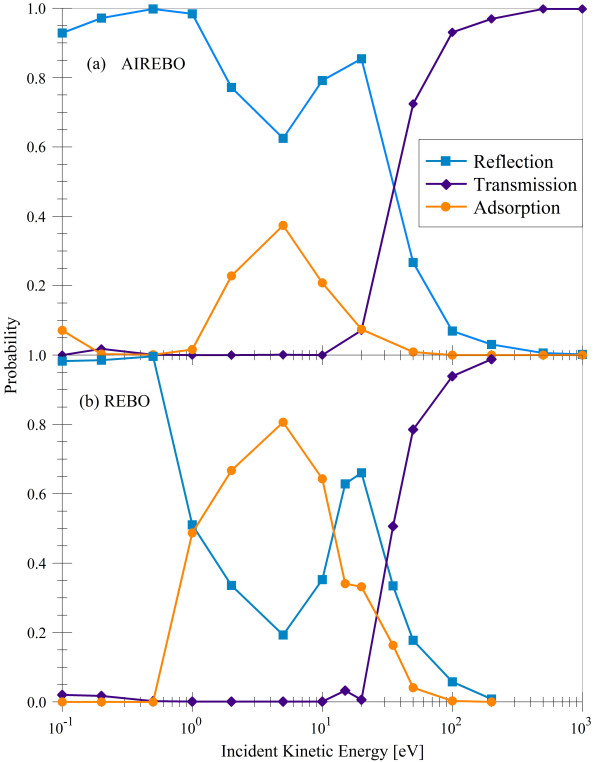
Probabilities of reflection, transmission, and adsorption as calculated by AIREBO and REBO [5,30]. The presence of potential barriers before potential wells (see Figure 10) results primarily in reflection at low incident energies.